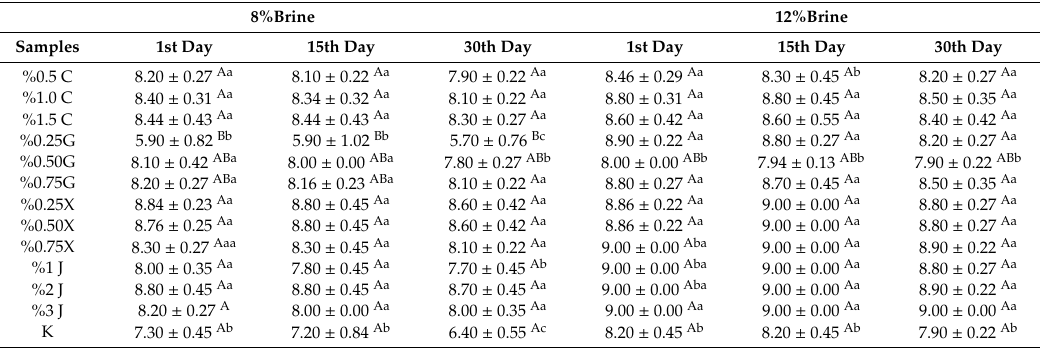
Table 13. Appearance score of cheese samples during